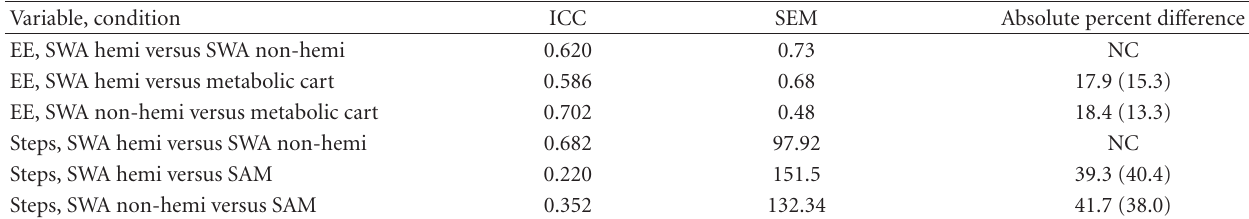
Table 3: Agreement, standard error of measurement, and absolute percent di ff erence by condition.